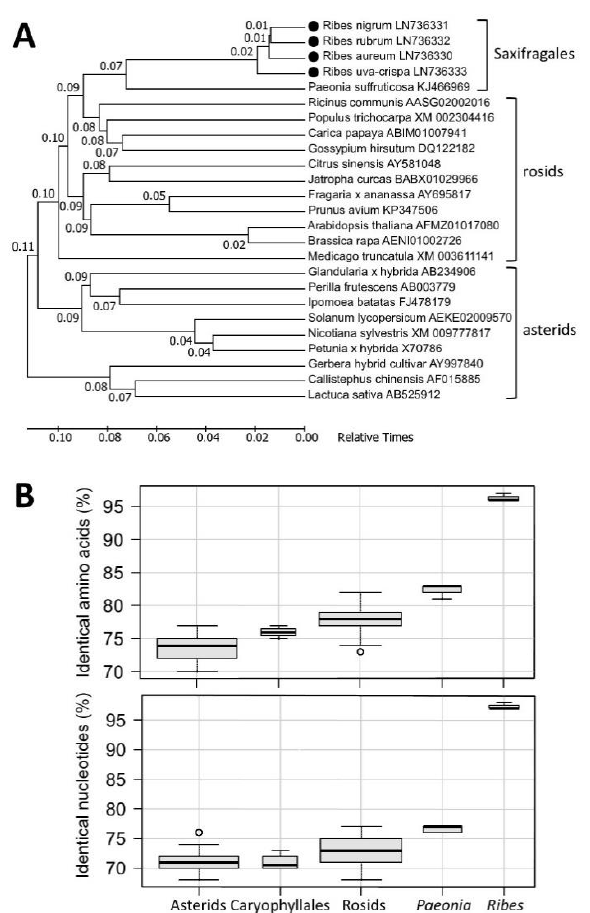
Figure 2. Similarity between ANS sequences from Ribes genus and other taxa. ( A ) A phylogenetic timetree of selected ANS protein sequences. Divergence times were calculated with the RelTime method using MEGA7. All proteins are named with the species name and accession number. ( B ) Boxplots showing the similarity between ANS sequences. Each boxplot shows the spread of percentages of identical residues in pairwise alignments between R. nigrum ANS and other ANS sequences. In each group (except Ribes and Paeonia ) each sequence aligned to R. nigrum ANS represents a different genus. The number of pairwise alignments in each group: asterids, 21; caryophyllales, 4; rosids, 22; Paeonia , 5; Ribes , 4.